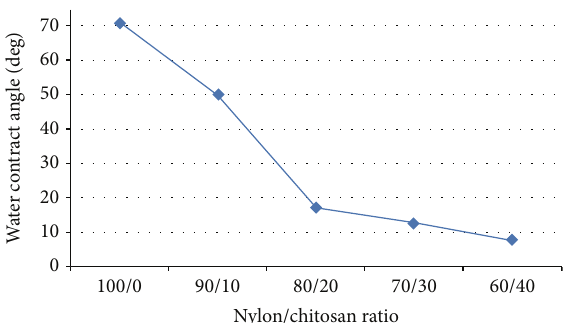
Figure 5: Water contact angle variations of various polyamide-6/chitosan electrospun nanofibrous